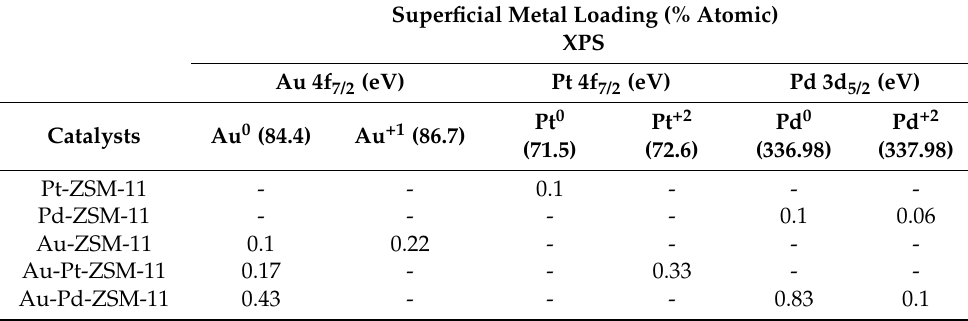
Table 2. Surface metal loading of monometallic and bimetallic